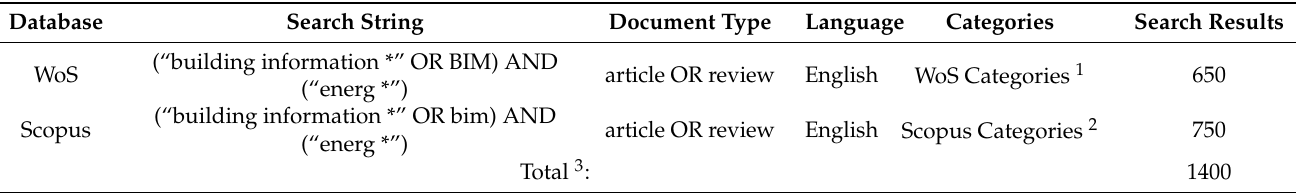
Table 2. Search strings in WoS and